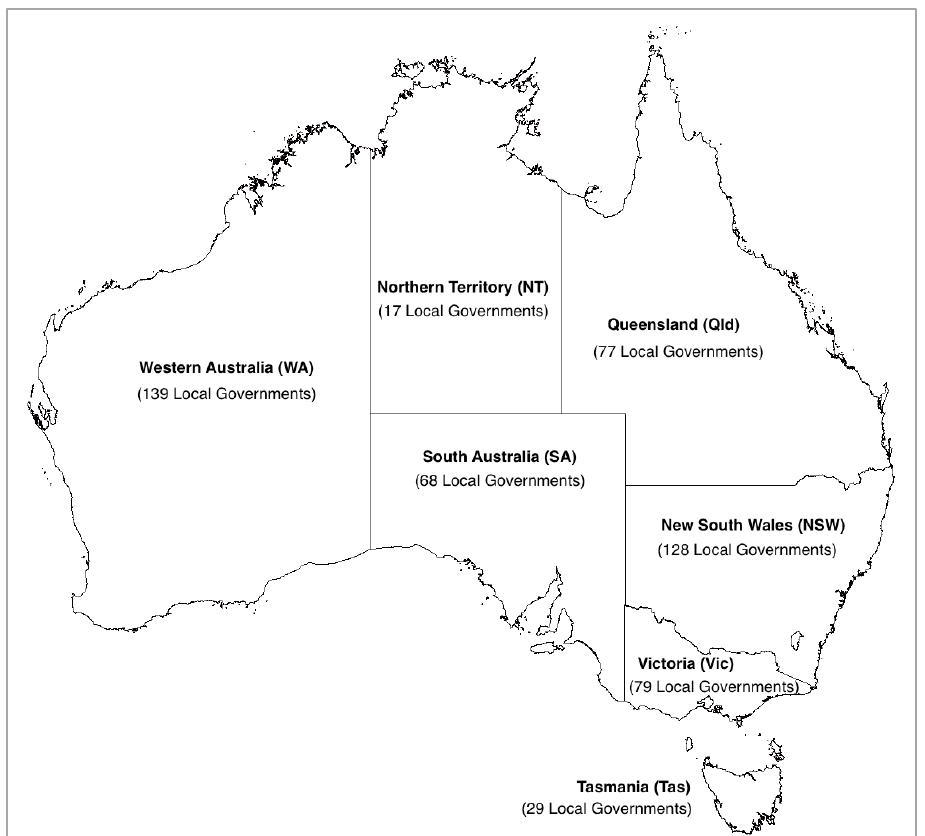
Figure 1: Map of Australian states with number of local